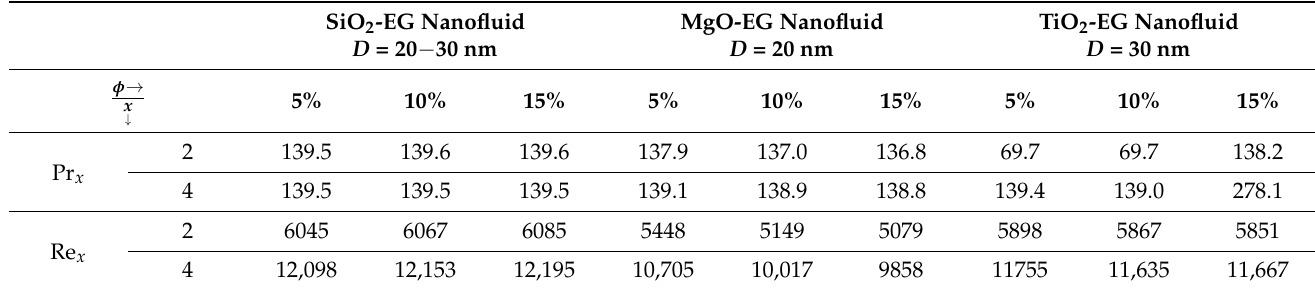
Table 4. The values of Pr x and Re x numbers at different nanoparticle concentrations.